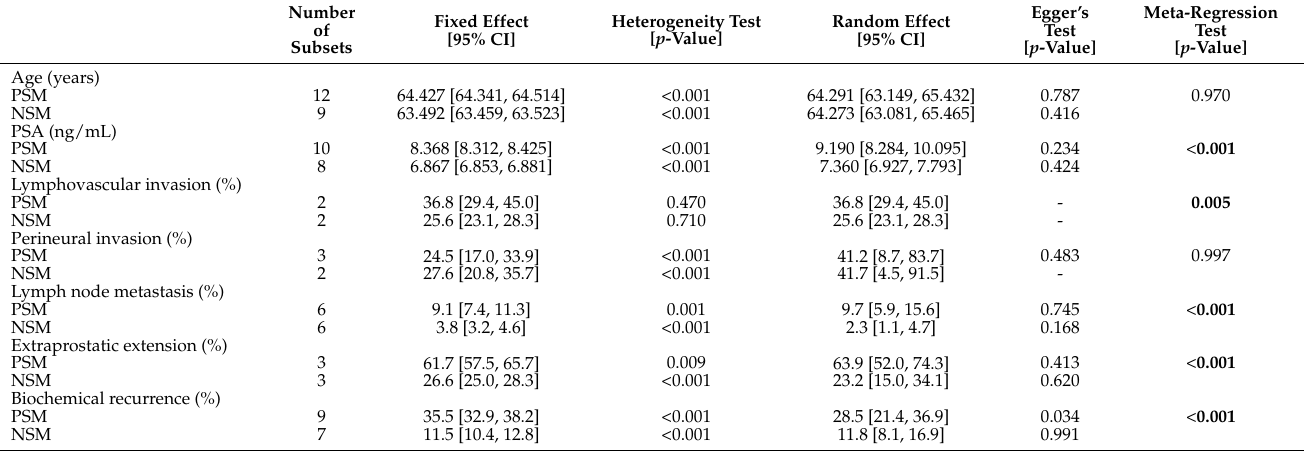
Table 4. Comparisons of clinicopathological parameters between positive and negative surgical margins after radical prostatectomy in prostatic